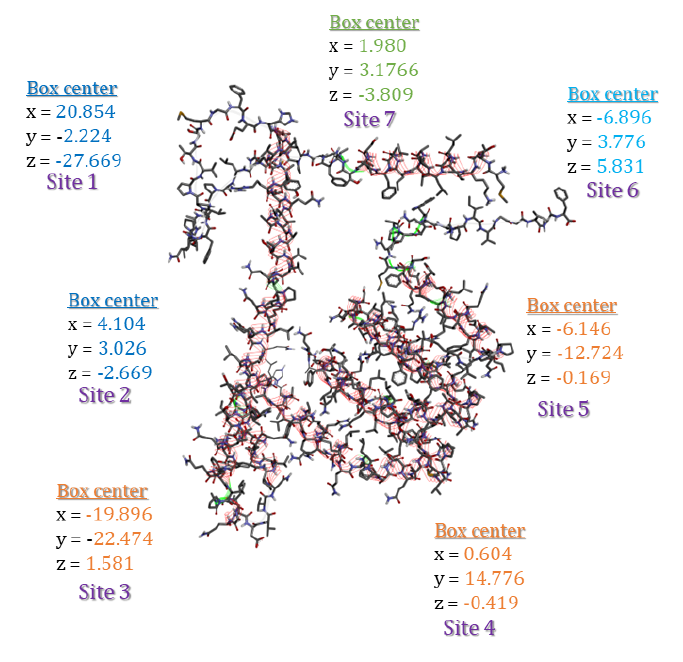
Figure 2. Different binding sites and their coordinates (x, y, and z) on the surface of the zein structures (Q9SYT3_MAIZE) using Discovery Studio Client v16 software.